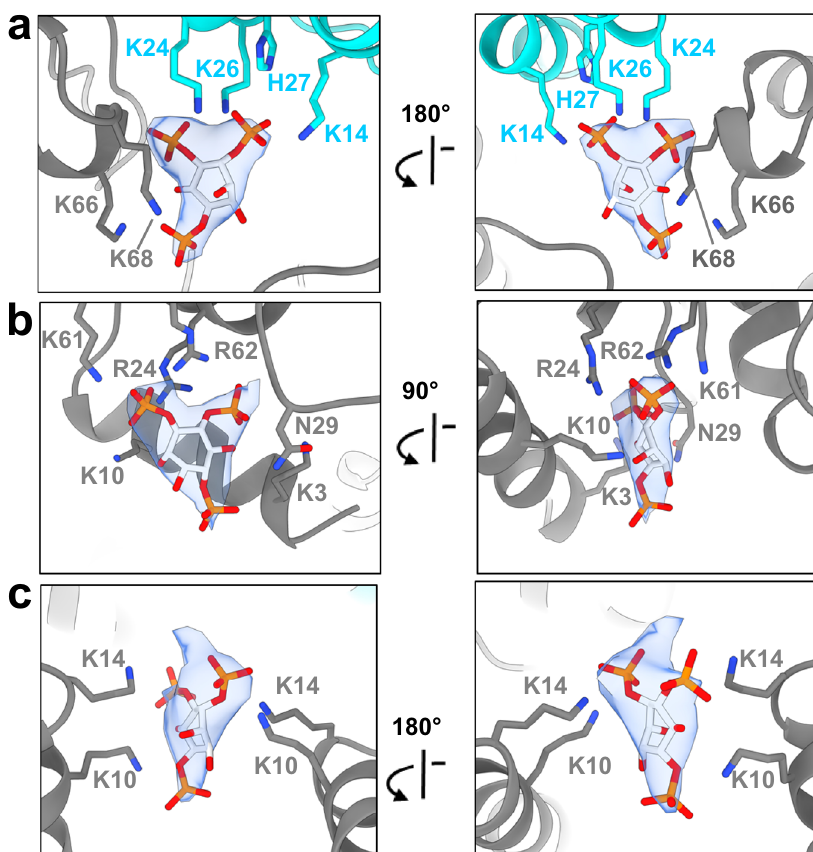
Fig. 2 PIP 2 binding sites in the AENTH tetramer. a PIP 2 binding site shared by the ANTH and ENTH domains. b PIP 2 binding site within the ENTH domain. c PIP 2 binding site in the interface between two ENTH domains. The residues involved in PIP 2 binding are shown in sticks and colored blue for nitrogen and gray and cyan for carbon in ENTH and ANTH, respectively. The polar head of the PIP 2 is shown in stick format and colored red, orange, and light gray for oxygen, phosphate, and carbon, respectively with the corresponding density shown as a transparent